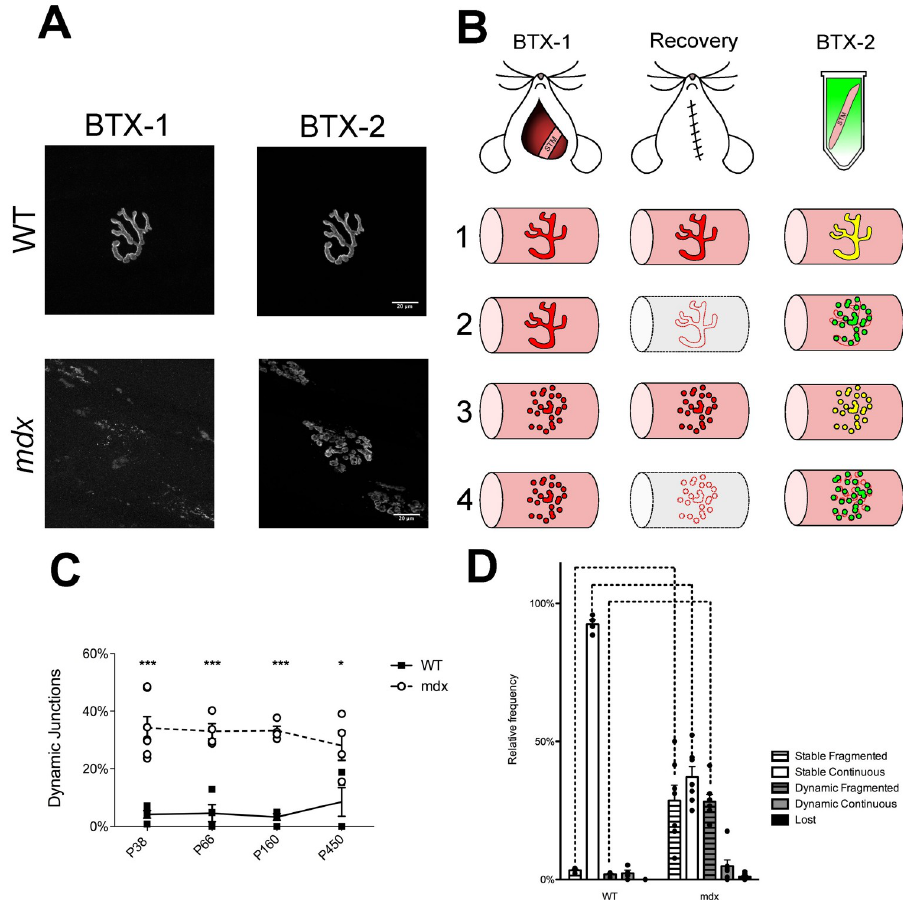
Fig 3. Receptor replacement and NMJ categorization following two-color BTX. (A) Maximum intensity projection images of STM whole mounts that have undergone the two-color BTX procedure. Examples are from P66 mice. BTX-1 is the first receptor label. BTX-2 is the second applied 10 days later. Imaging follows muscle dissection. In mdx there is a loss of BTX-1 and frequently the BTX-2 label shows fragmentation. Scale bar = 20 μ m (B) Two-color BTX experimental design. The STM of mice was exposed and labeled with BTX-1 at Day 0. The animal was allowed to recover from the surgery for 10 days and then euthanized. The labeled muscle was dissected from the animal and labeled with BTX-2. The lower portion of (B) illustrates four predicted outcomes of the experiment. In red is a possible morphology of BTX-1 labeled AChR aggregates at Day 0 of the experiment, in green BTX-2 label at Day 10. Colocalization of BTX-1 and BTX-2 is indicated with yellow. Intact myofibers are shown as pink tubes, and a degenerating myofiber is shown as a gray tube. Scenario 1 shows a stable, continuous junction. 2 a dynamic, fragmented junction. 3 a stable fragmented junction, and 4 another dynamic, fragmented junction. (C) Receptor replacement in WT and mdx STM. Receptor replacement, calculated as percentage of dynamic junctions, in mdx mice is constantly elevated compared to WT. Asterisks denote significance ( � P < 0.05, ��� P < 0.001, 2-Way ANOVA, Bonferroni post-hoc test). No effect of age was found on receptor replacement. (D) Categorization of P38 WT and mdx junctions following two-color BTX. Bars below labels denote significant difference within genotypes. Not all significant differences within genotypes are shown for sake of brevity. Dashed lines above graph denote significance between genotypes (2-Way ANOVA, Bonferroni post-hoc test, P < 0.05). A full account of statistical significance can be found in S1 Table. Exact n can be found in text as t(df) = t-value. n = df + 2. n is number of mice